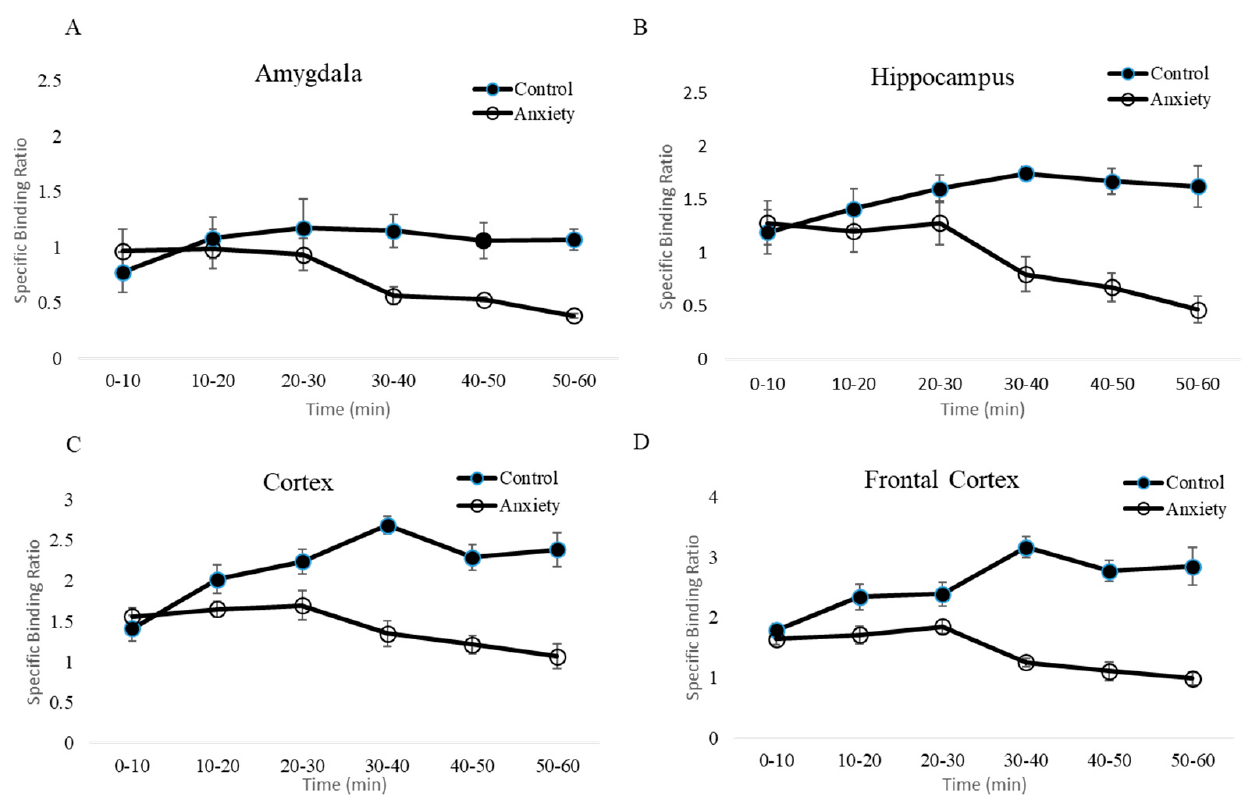
Figure 5. [ 18 F]flumazenil time-activity curve for the fear-conditioned (anxiety) and control rats. ( A – D ) Separate displays of the time-activity curves from the amygdala, hippocampus, cortex and frontal cortex, respectively. The time-activity curves were generated by projecting the specific up- take ratios, calculated from the pre-defined ROIs, onto the dynamic images. Based on comparisons to the reference region, the specific binding ratios in the control group were significantly higher than those in the fear-conditioned group in the four target regions.